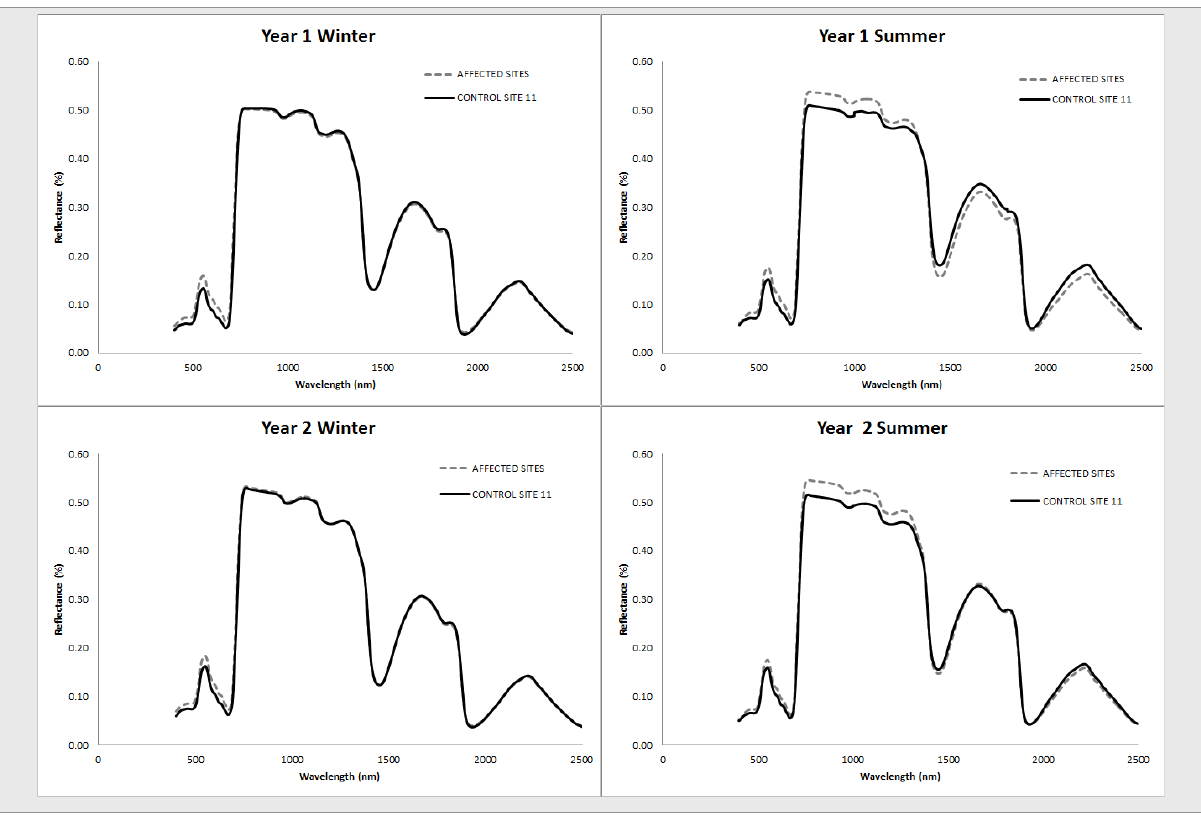
Figure 2: Average leaf reflectance (%) of green leaves at sites affected by acid mine drainage compared to the control site, per season and year.